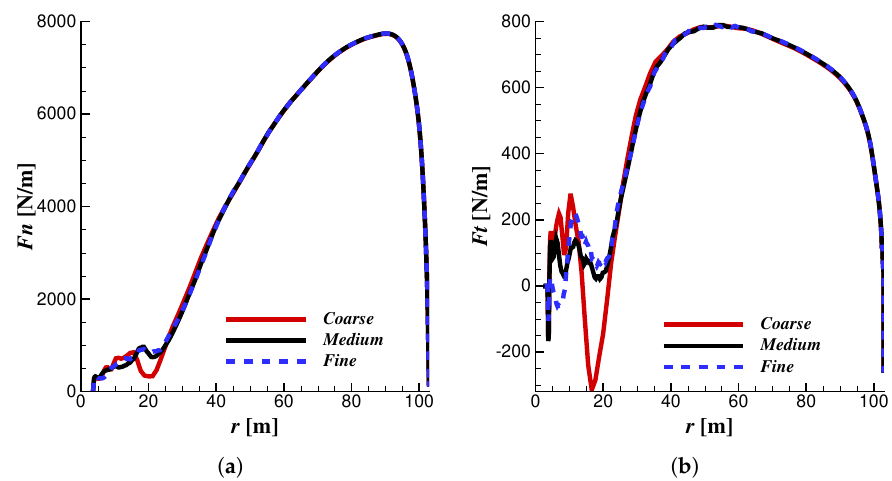
Figure 7. Grid density influence on the sectional loads predictions of the generic 10 MW AVATAR blade; ( a ) normal force, ( b ) tangential force. Table 2. Grid convergence study for the AVATAR blade using the GCI approach. Data are obtained from the URANS